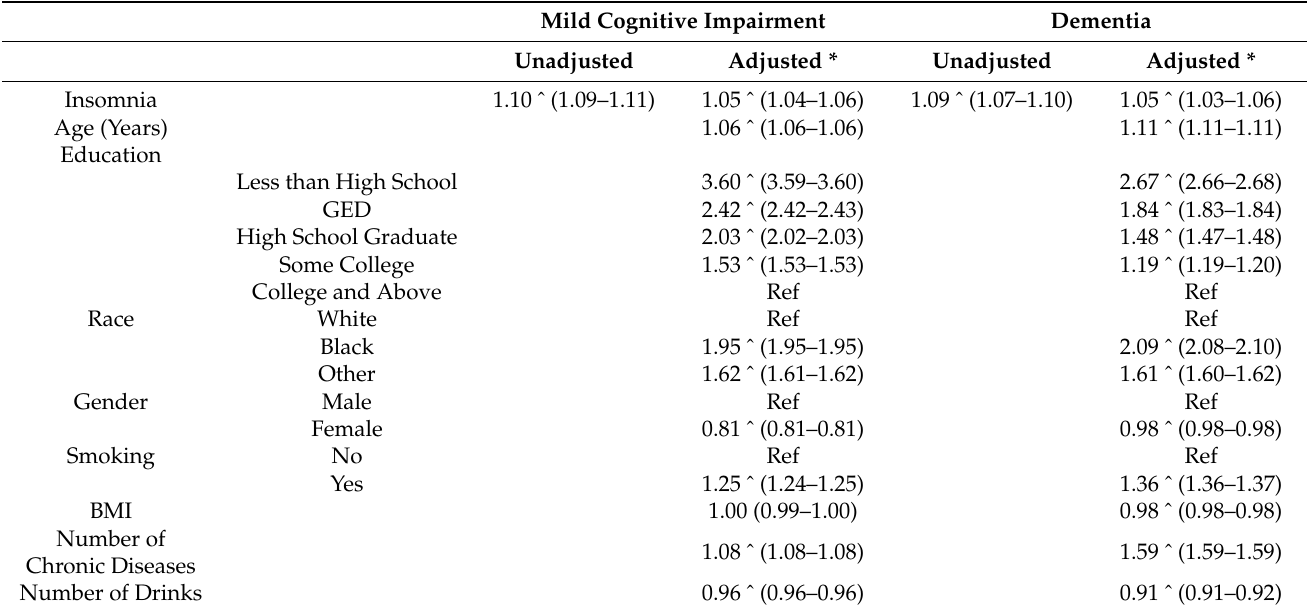
Table 2. Unadjusted and adjusted hazard ratios between time-varying insomnia, mild cognitive impairment, and dementia. Mild Cognitive Impairment Dementia Unadjusted Adjusted *